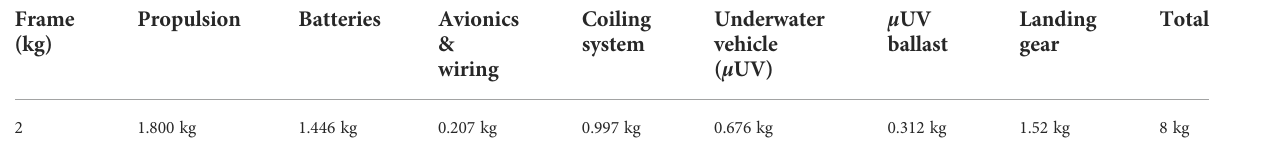
TABLE 1 Masses of principal components in the MEDUSA system. Frame